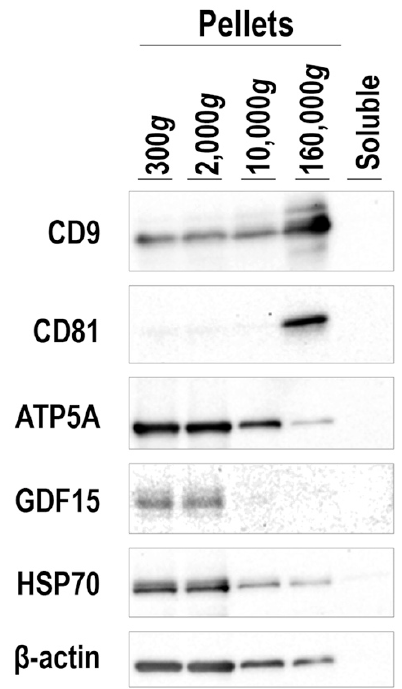
Figure 8. Culture supernatant of hESC-derived BAs was subjected to sequential centrifugation with stepwise increasing gravities as indicated. Western blotting was performed by applying aliquots of lysed pellets obtained in each step using indicated antibodies. “Soluble” indicates the supernatant after centrifugation at 160,000× g.